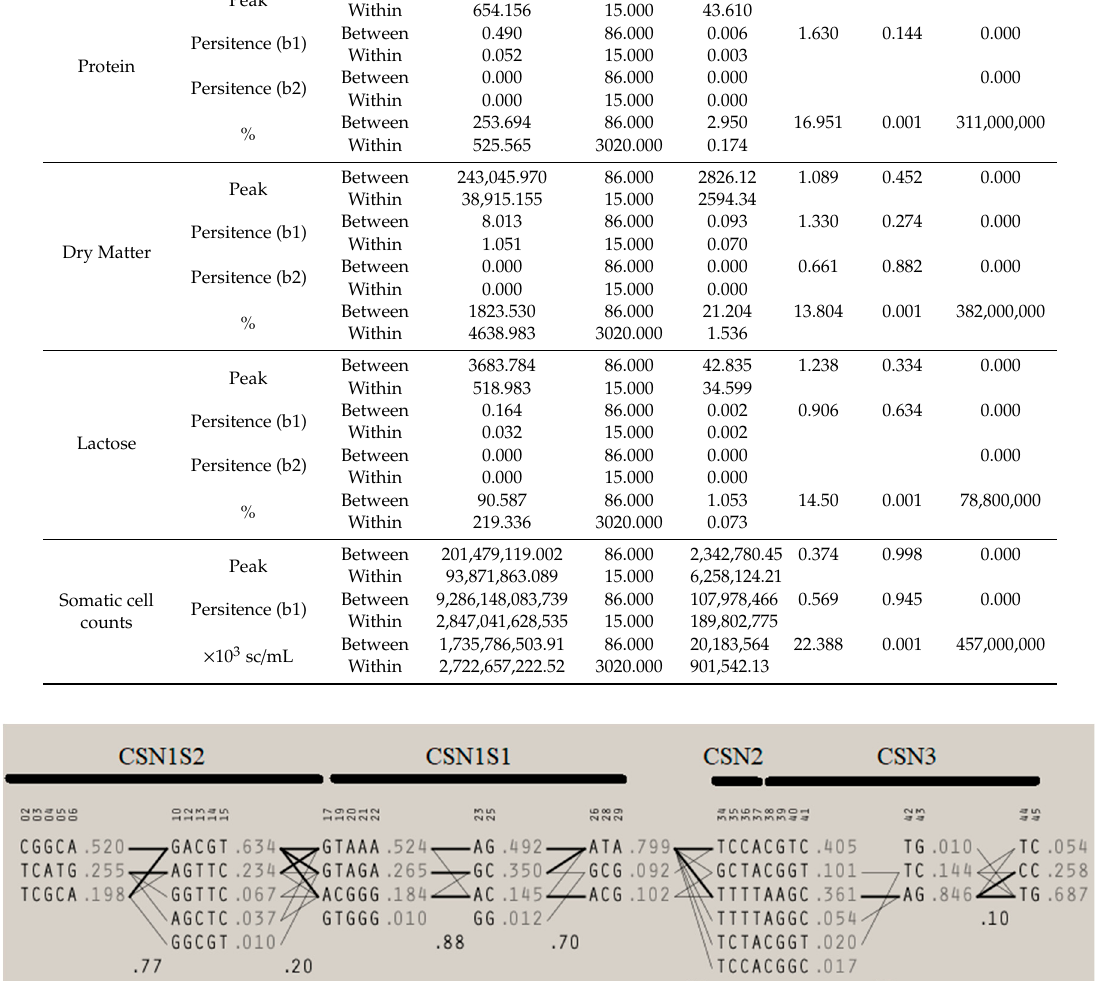
Figure 1. Linkage disequilibrium map across casein complex loci (CSN1S1, locus for α S1-casein; CSN1S2, locus for α S2-casein; CSN2 locus for β -casein; and CSN3, locus for κ -casein). Accessed from Pizarro Inostroza et al. [5].